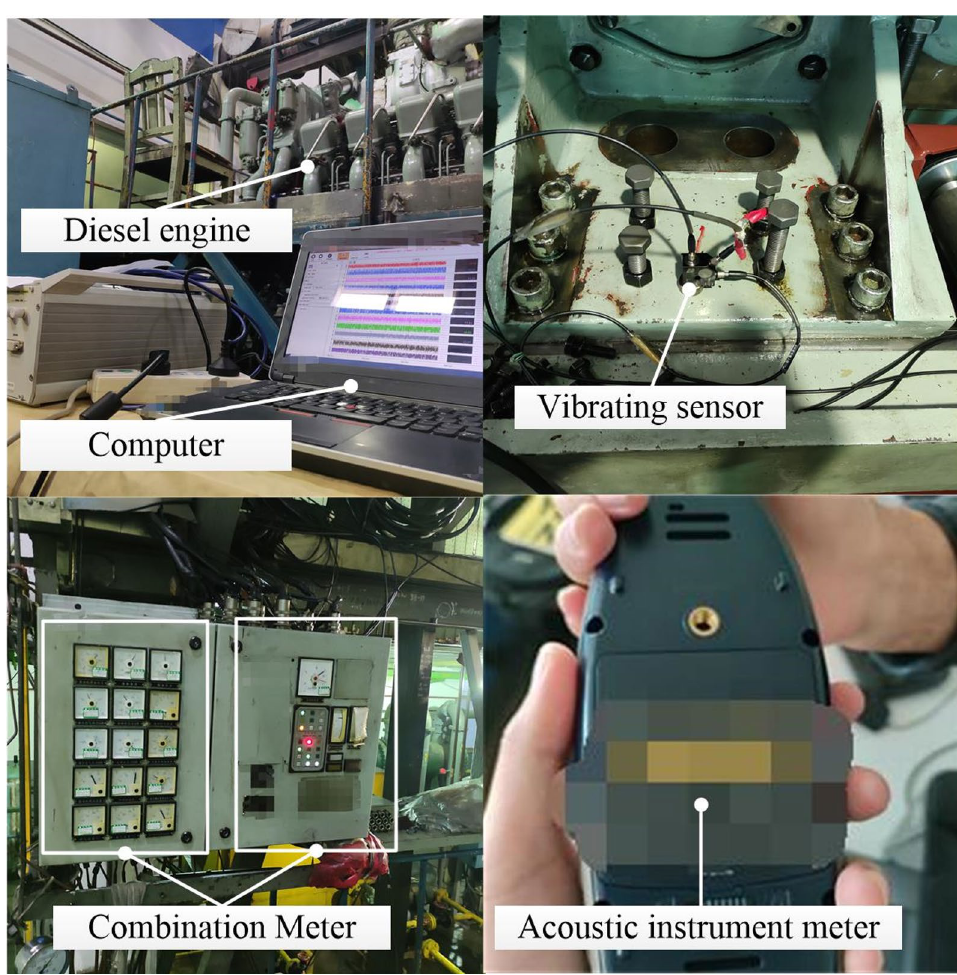
Figure 2. The performances measurement for the multicylinder engine in